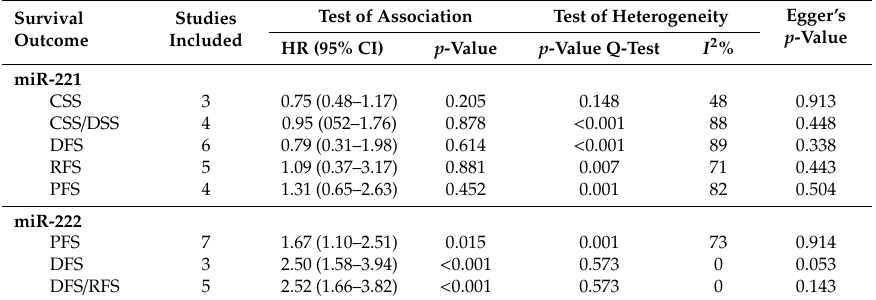
Table 4. Summary of meta-analyses for the association between high miR-221 / 222 expression and survival outcomes in cancer